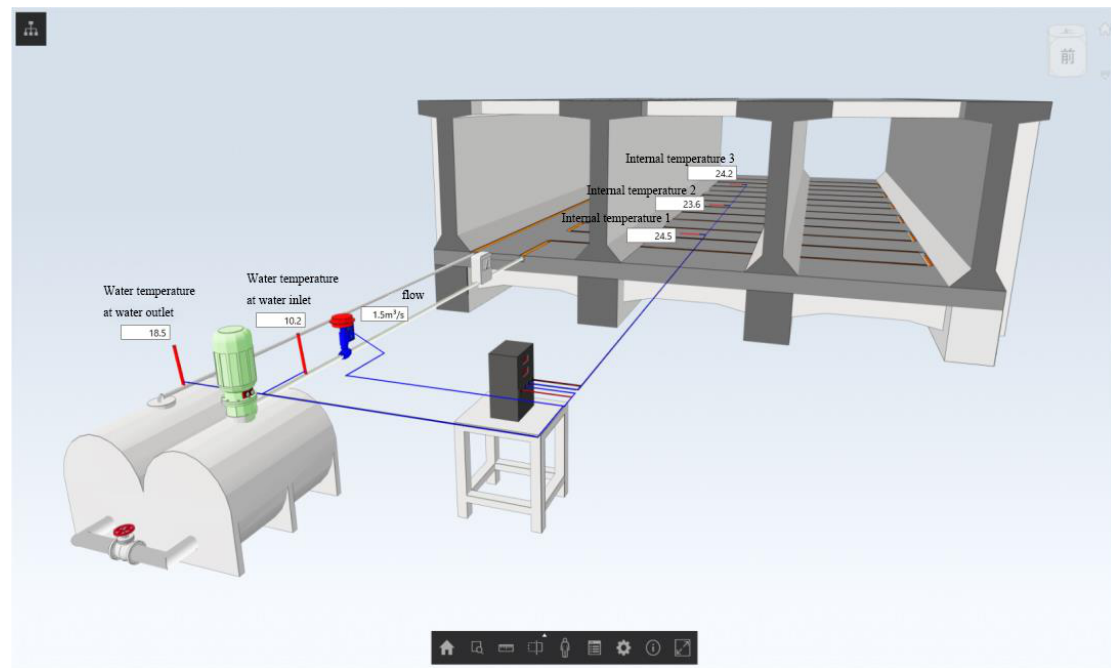
Figure 14. Experimental aqueduct model.